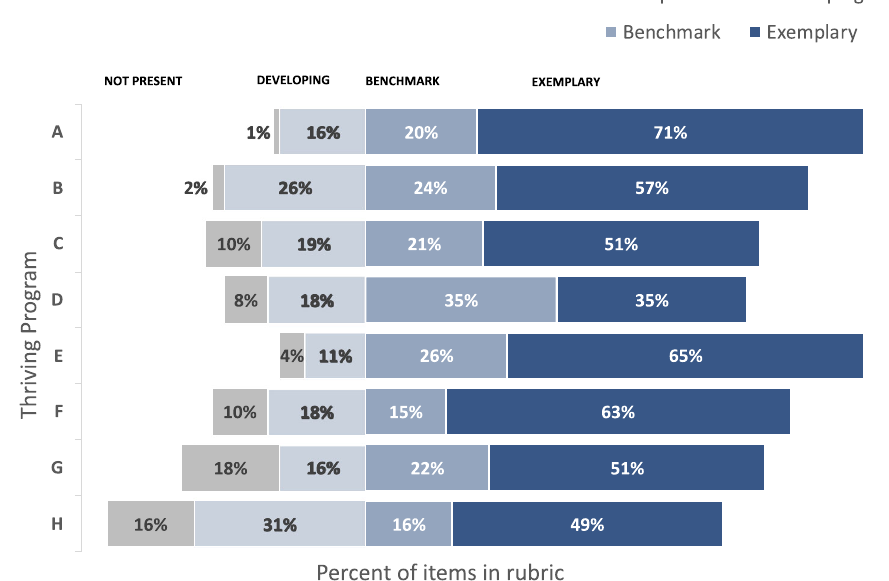
FIG. 4. Percent of items rated at each level across all eight studied programs, on the entire rubric. Percentages are out of the number available ratings per standard (No. of items total × 8